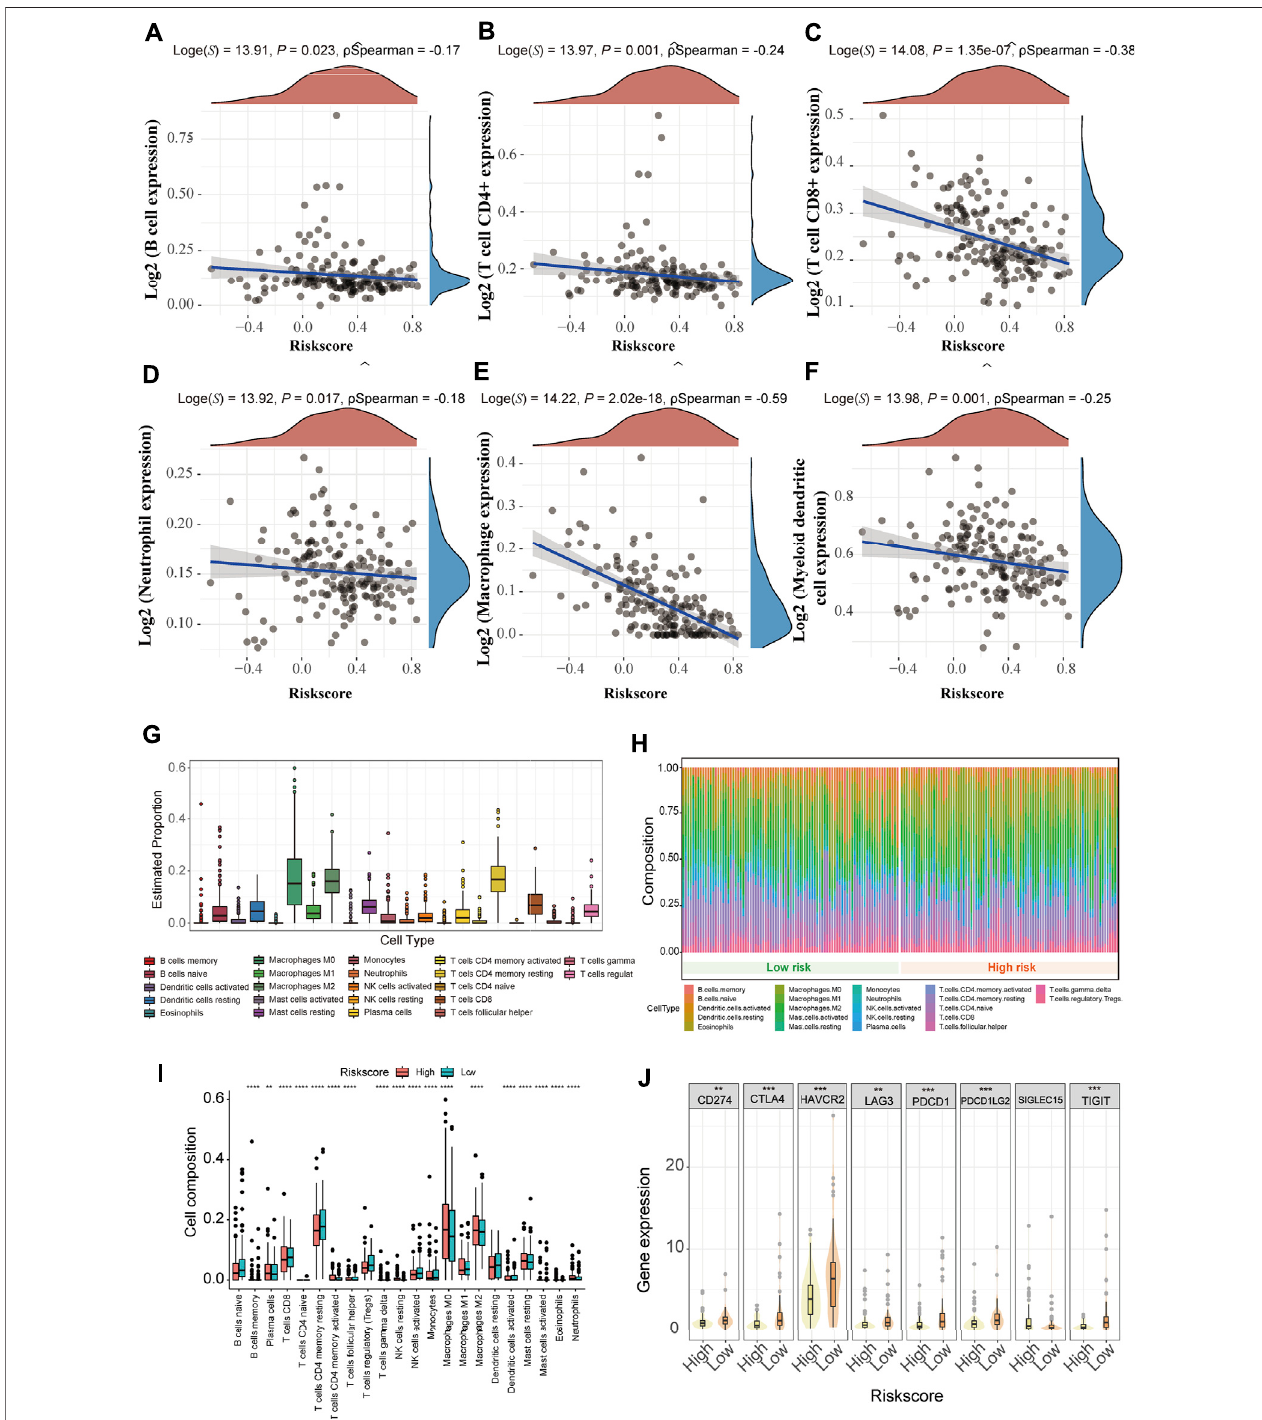
FIGURE 8 | Immune landscape and immune therapy prediction of the 3-gene signature in the TCGA cohort (A-F) The correlation between risk score and six immunein fi ltratingcells(Bcells,CD4 + Tcells,CD8 + Tcells,Neutrophils,Macrophages, andDendriticcells) (G) Theproportion of22types ofimmunecellsinthetotalPC samples (H) There are relative proportions of 22 types of immune cells between the high and low-risk subgroup (I) The difference in composition of the 22 types of immune cells between two risk subgroups. * represents p < 0.05; ** represents p < 0.01; *** represents p < 0.001 (J) The expression level of eight immune checkpoint family genes between two risk subgroups.